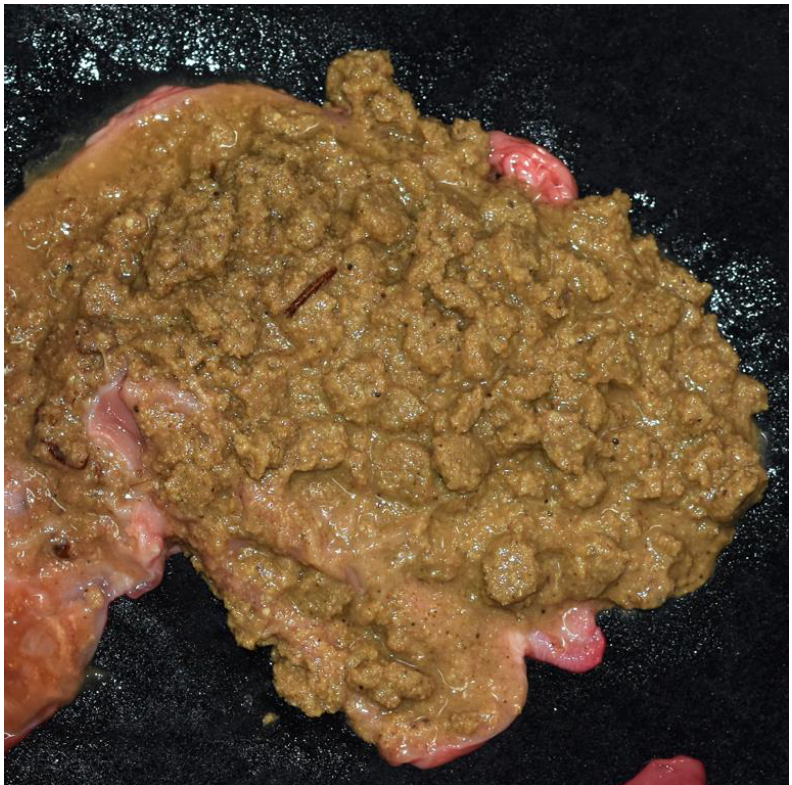
Figure 6. Gastric contents in the stomach of a cat. A large amount of gastric content with undigested food remains, which were identified as kibbles. The kibbles were considered human-provided food.